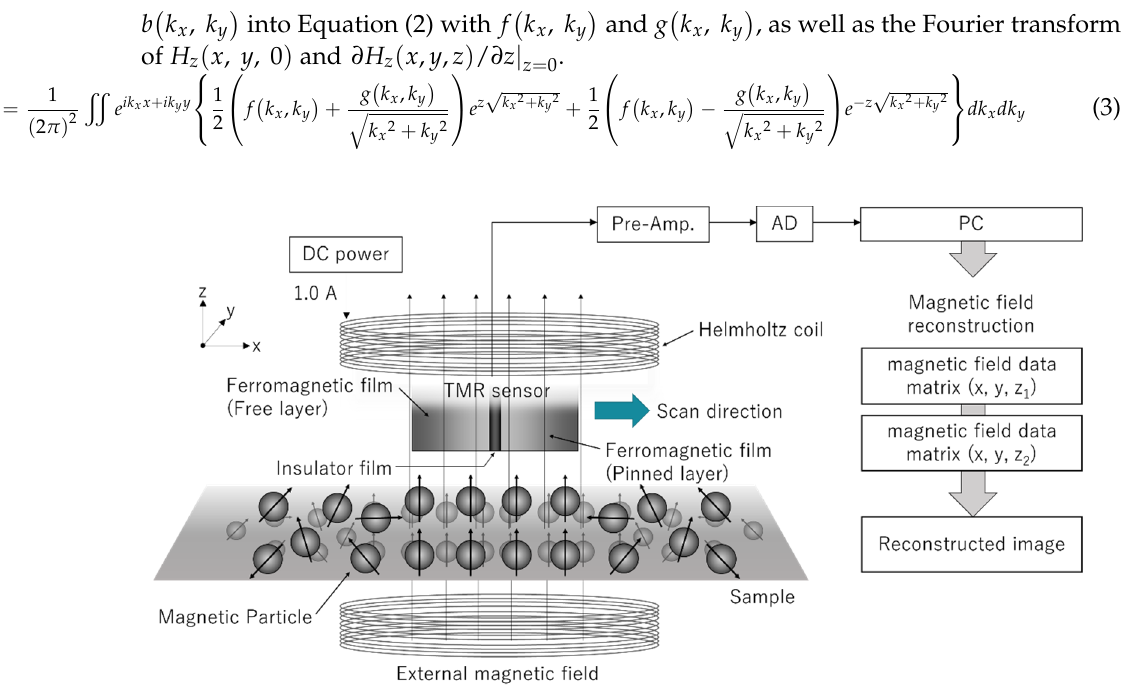
Figure 7. Two-dimensional magnetic particle distribution measurement system utilizing image reconstruction and a high-sensitivity magnetic sensor. A magnetic field from the Helmholtz coil is applied to magnetic particles, while a magnetic sensor scans magnetic field distribution along the surface using the stepping motor. The Helmholtz coil is not used in the case of a magnet not requiring magnetization. Image reconstruction was performed on the basis of obtained magnetic field measurement data.